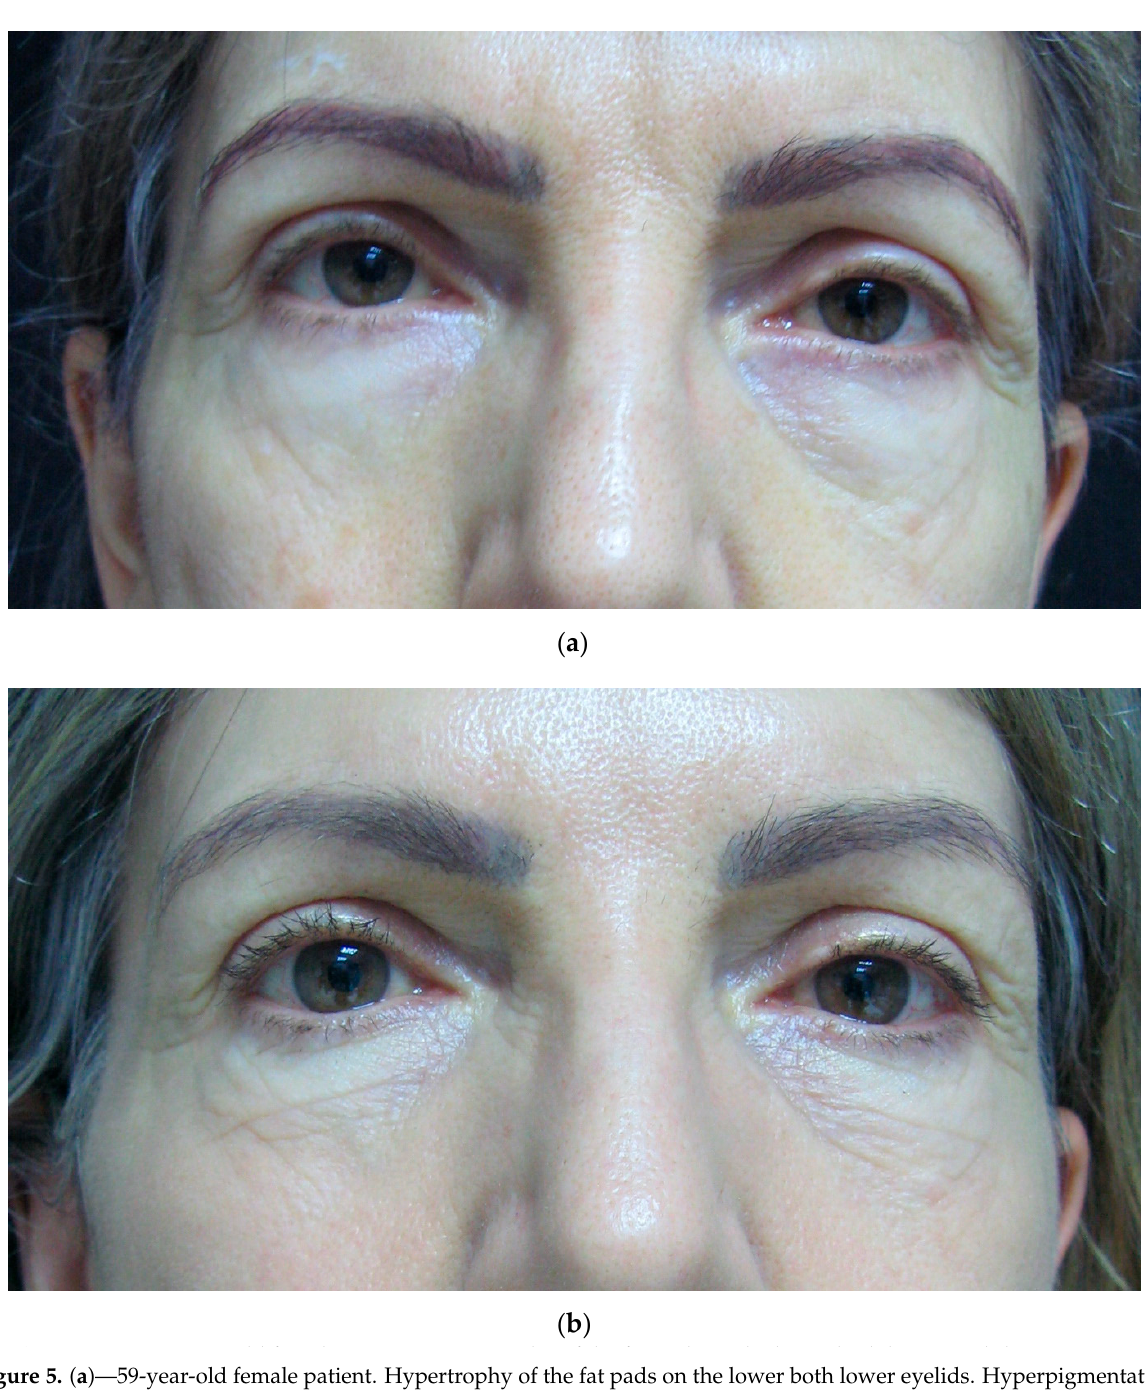
Figure 5. ( a )—59-year-old female patient. Hypertrophy of the fat pads on the lower both lower eyelids. Hyperpigmentation and tear through deformity on the lower left eyelid. ( b )—Improvement of the pigmentation after two of sessions of Q-switched 1064 nm. Improvement of tear through deformity with hyaluronic acid injection. Fat pad hypertrophy treated with transconjunctival blepharoplasty.